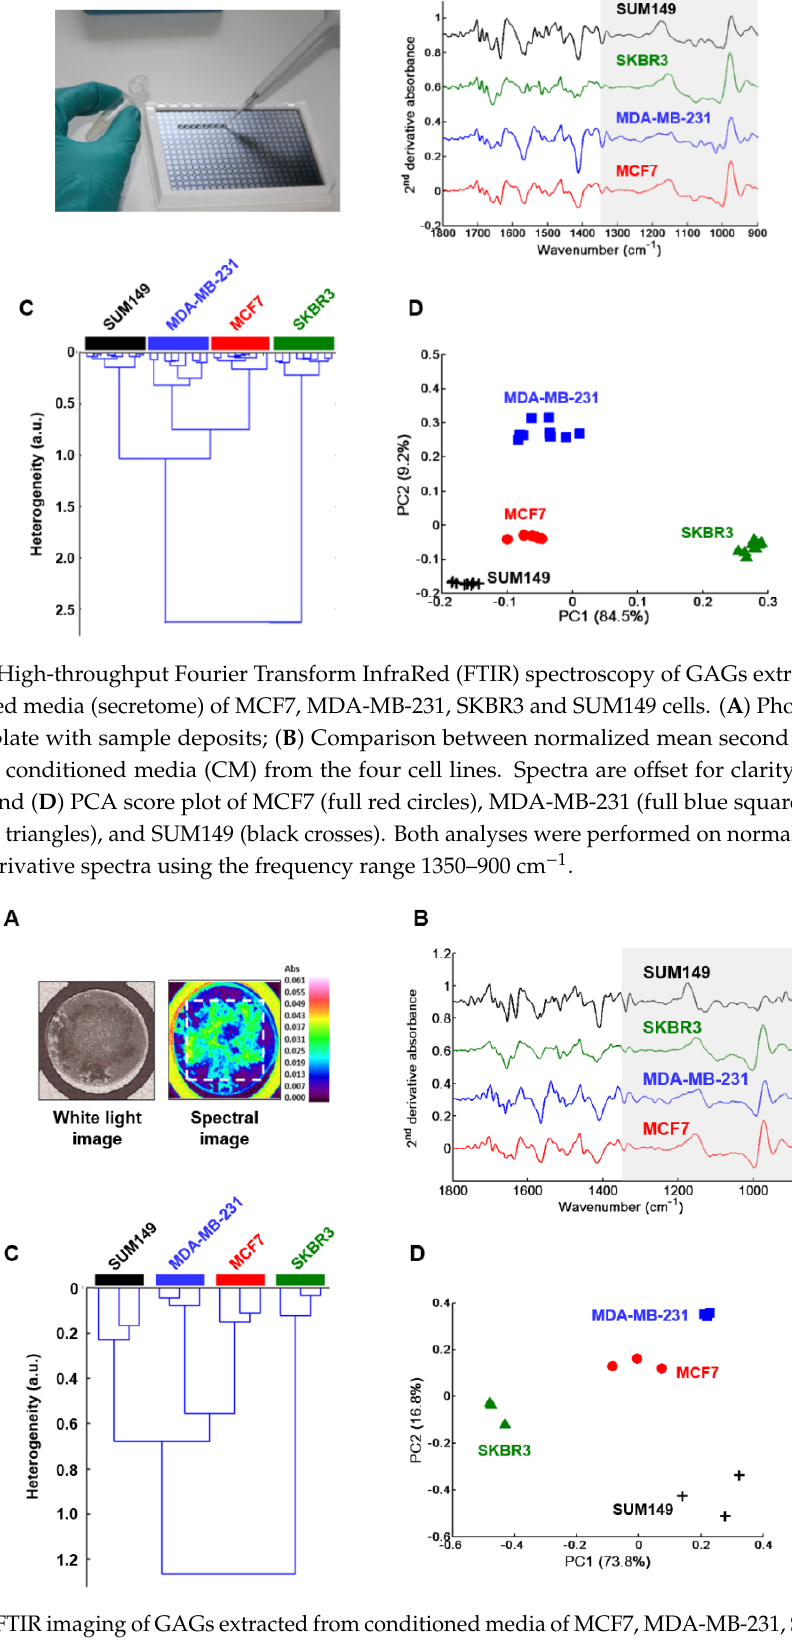
Figure 2. FTIR imaging of GAGs extracted from conditioned media of MCF7, MDA-MB-231, SKBR3 and SUM149 cells. ( A ) Illustration of the white light image of a GAG dried drop (left) and its